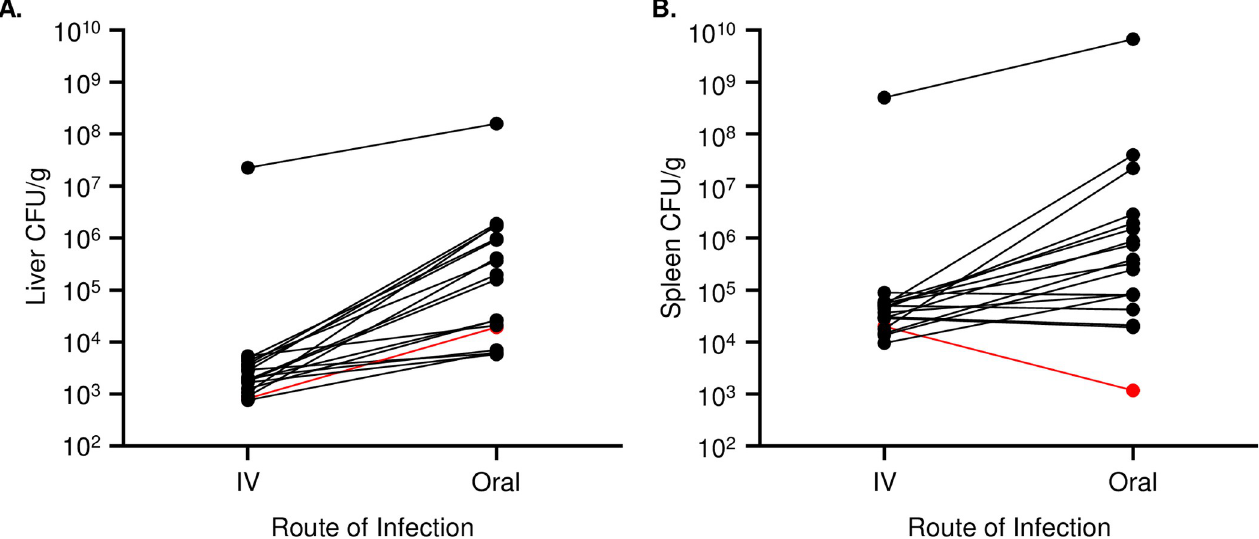
Fig 1. CC strains infected orally with STm are more highly and variably colonized than after IV infection. A. Liver and B. spleen colonization (median) for 18 CC strains orally infected in this project and infected intravenously in the previous work by Zhang, J. et al. 2018 [40]. Strains are connected by lines, and the red line represents